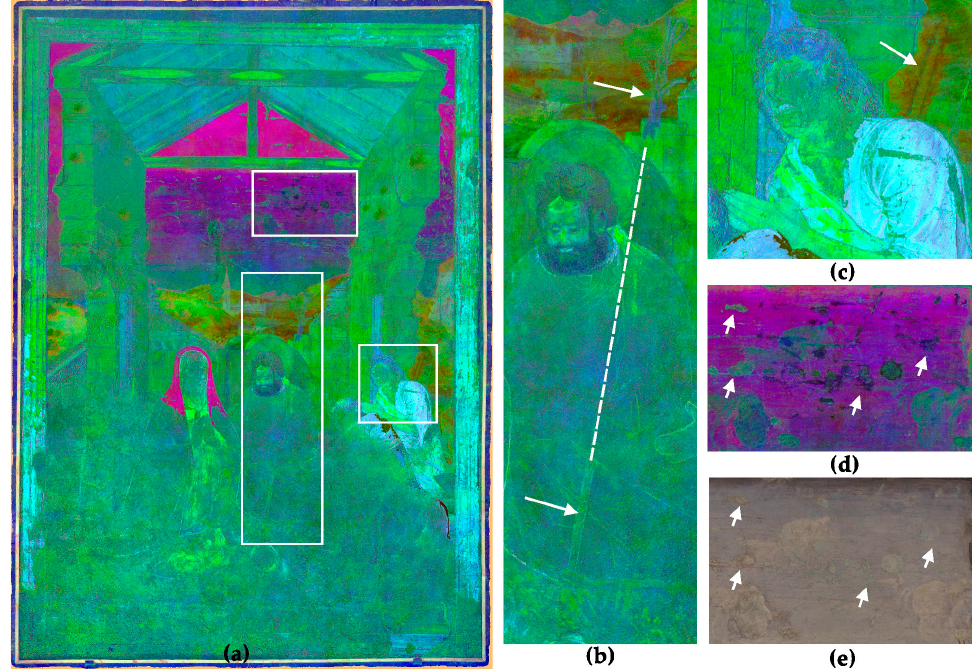
Figure 9. ( a ) Hybrid image based on the combination of PC3, 4 and 5. The image helps to localise covered underdrawings and material differences (highlighted with arrows): ( b ) features and tracing of a rod belonging to Joseph; ( c ) pentimenti of a not-realised shepherd’s crook; ( d ) surface damages and restorations with different materials; ( e ) same detail in VIS-R _VIS .